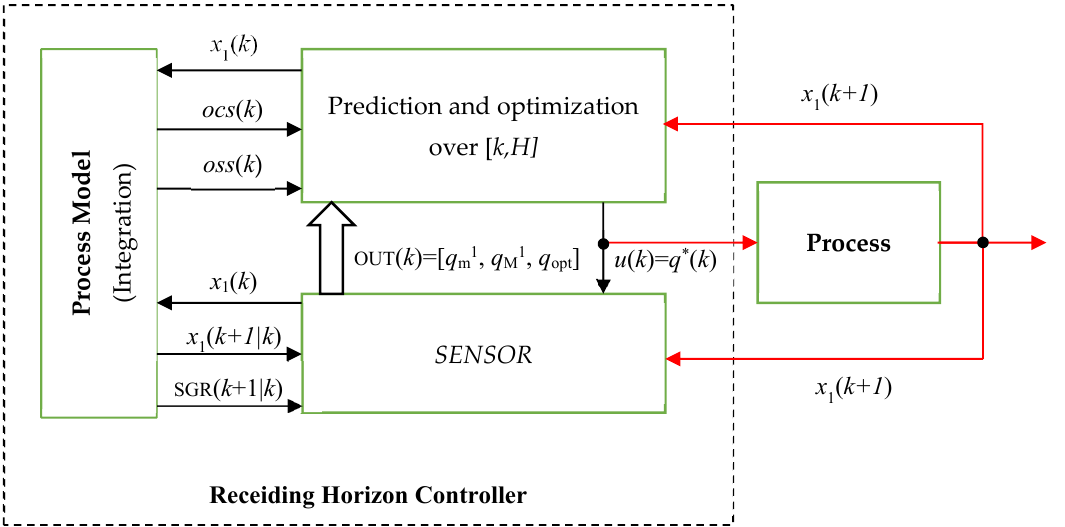
Figure 3. Receding Horizon Controller with sensor.